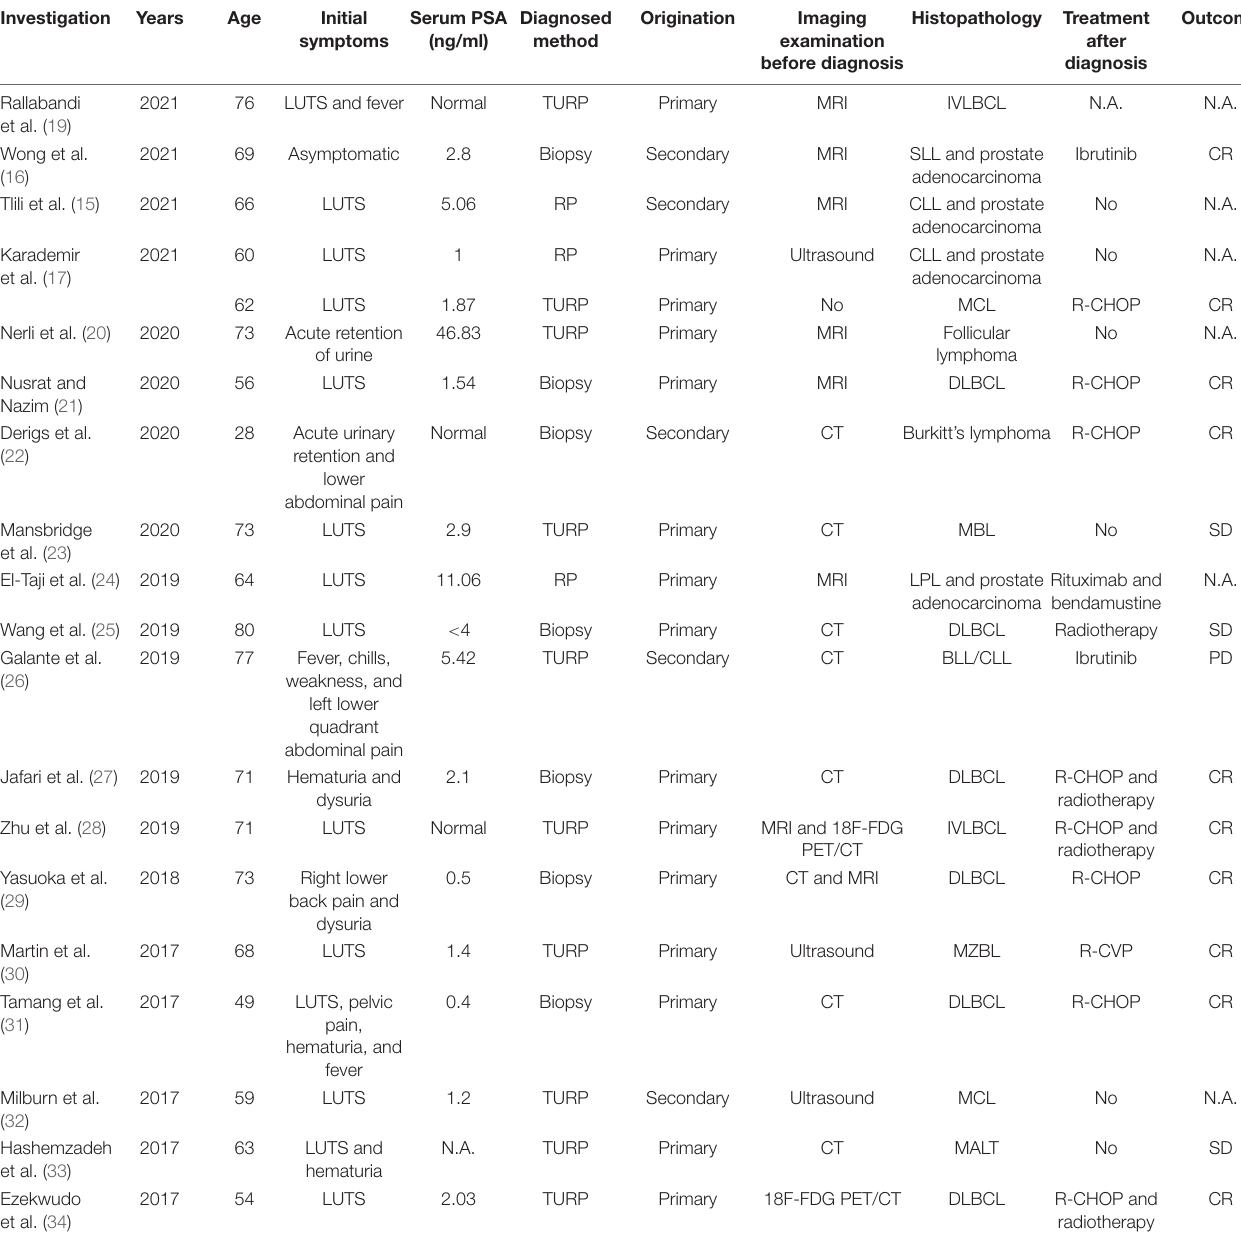
TABLE 1 | Reported cases of prostate lymphoma in the past few